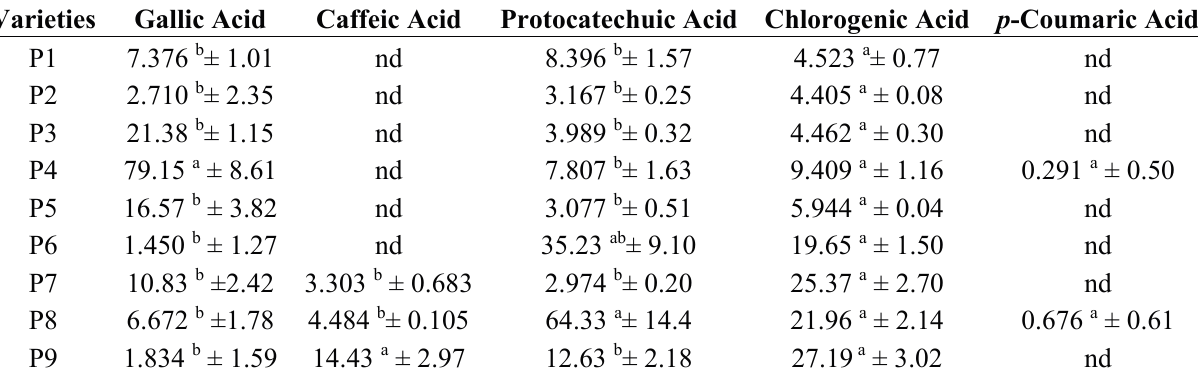
Different letters (a–e) within the columns indicate significant difference at p < 0.05; values are the means of three replicates ± SD; nd.: not detected. Table 4. Phenolic acids content (mg/100 g FW) in the peel samples of mango